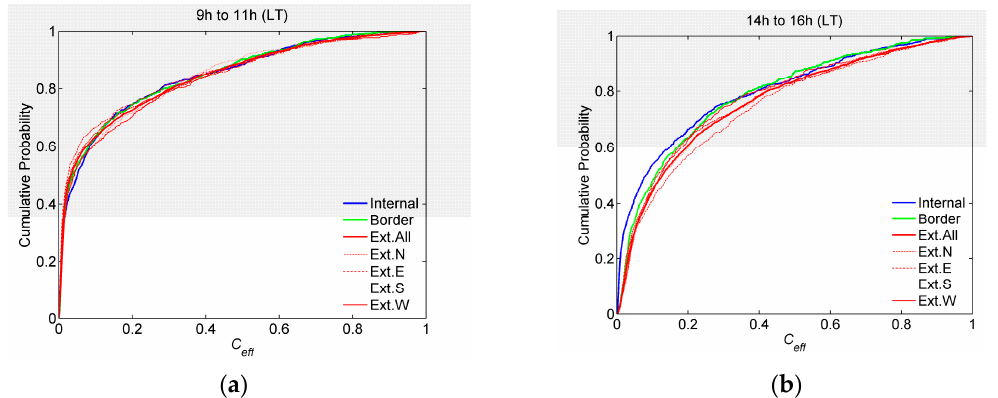
Figure 10. The cumulative distribution functions (CDF) charts for e ff ective cloud cover C ef f levels for each target area during the ( a ) morning and ( b ) afternoon periods.